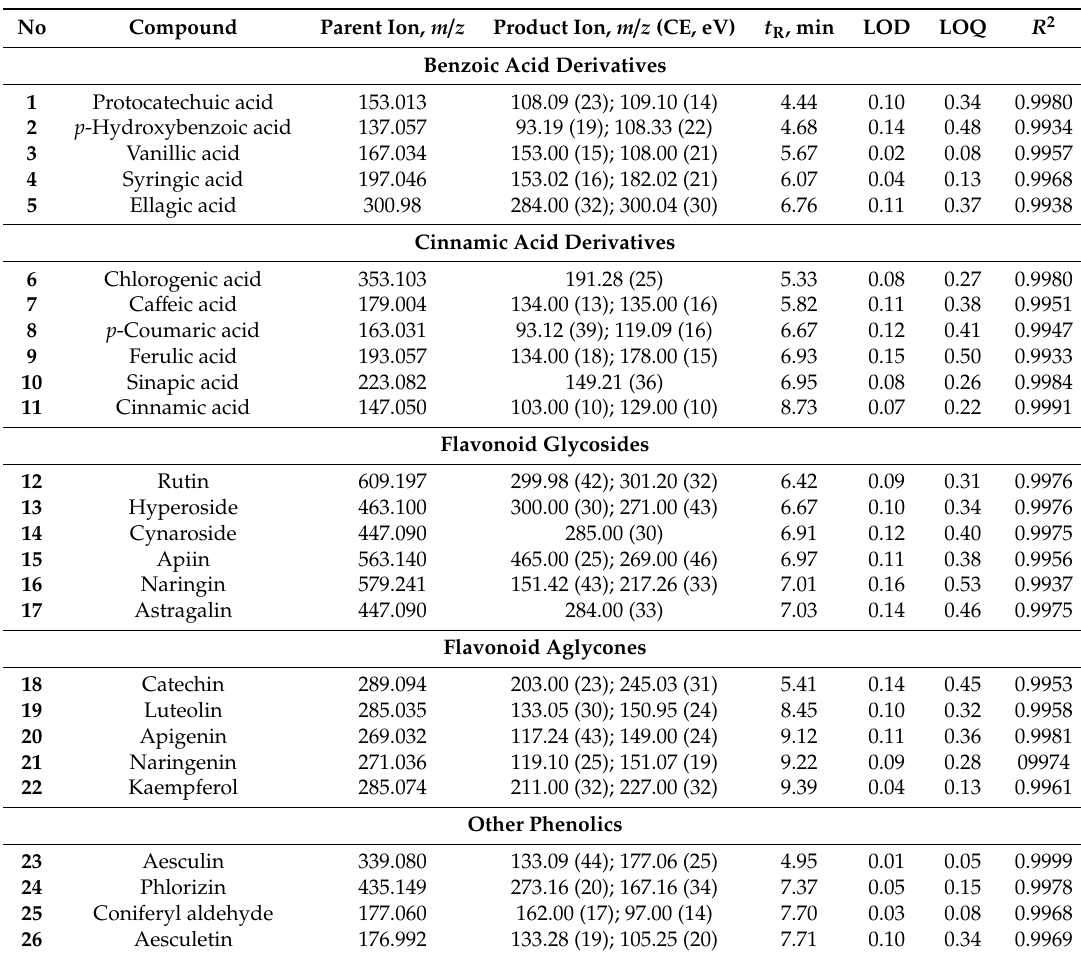
Table 2. List of quantified phenolics in in negative ion mode: Parent ion ( m / z ), product ions ( m / z ) with specified collision energy (CE, eV), mean expected retention time ( t R , min), limit of detection (LOD, mg / L) and quantification (LOQ, mg / L), and correlation coe ffi cient ( R 2